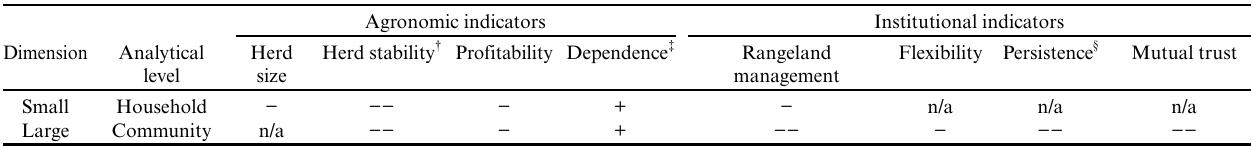
Table 3. Resilience of the current social subsystem to drought, specified for the analytical levels of household and community, based on agronomic and institutional indicators. The resilience assessment focuses on the potential of management practices to mitigate drought effects on herds, and on the viability of institutions governing natural resource use. Practices and institutions in traditional pastoral social-ecological systems are used as a baseline. Profitability is compared to market-oriented farming practices. Positive signs (+) represent high resilience compared to the baseline; negative signs represent low (−) or very low (−−) resilience; n/a = not